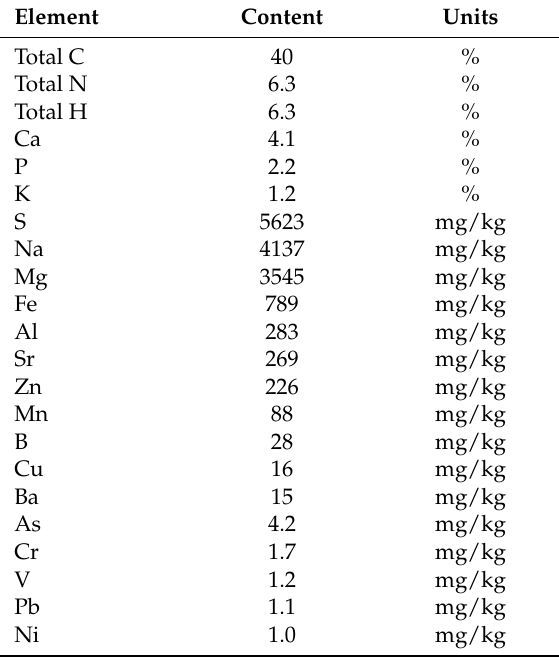
Figure 3. Cut away view of the bubble bead filter. Here you can see the shape, setup, and bead orientation during normal operation [15]. Table 1. Blackwater Creek Farm Max Growth formula elemental contents via hot plate acid digestion.